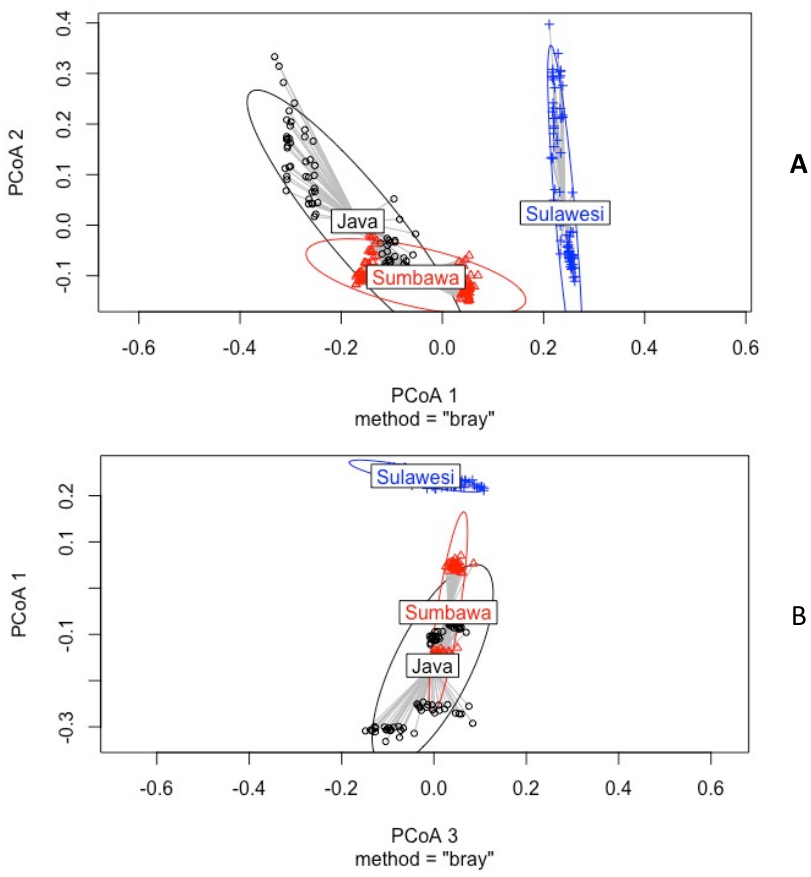
Figure 6. Plot of the groups and distances to centroids based on PCoA1 and PCoA2 ( A ) and based on PCoA3 and PCoA1 ( B ) between islands. Ambrosia beetle communities between teak managements were different between both teak managements, as confirmed by analysis of variance based on homogeneity of multivariate dispersion (sig. 0.001) and permutation test for homogeneity of multivariate dispersions (sig. 0.01). Based on the eigenvalues for PCoA axes, plots of the groups of teak managements are visualized as shown in Figure 7. Both teak managements (thinning and non ‐ thinning) overlap each other, as is shown in Figure 7A (based on PCoA1 and PCoA2). The same tendency is also described in Figure 7B (PCoA1 and PCoA3).